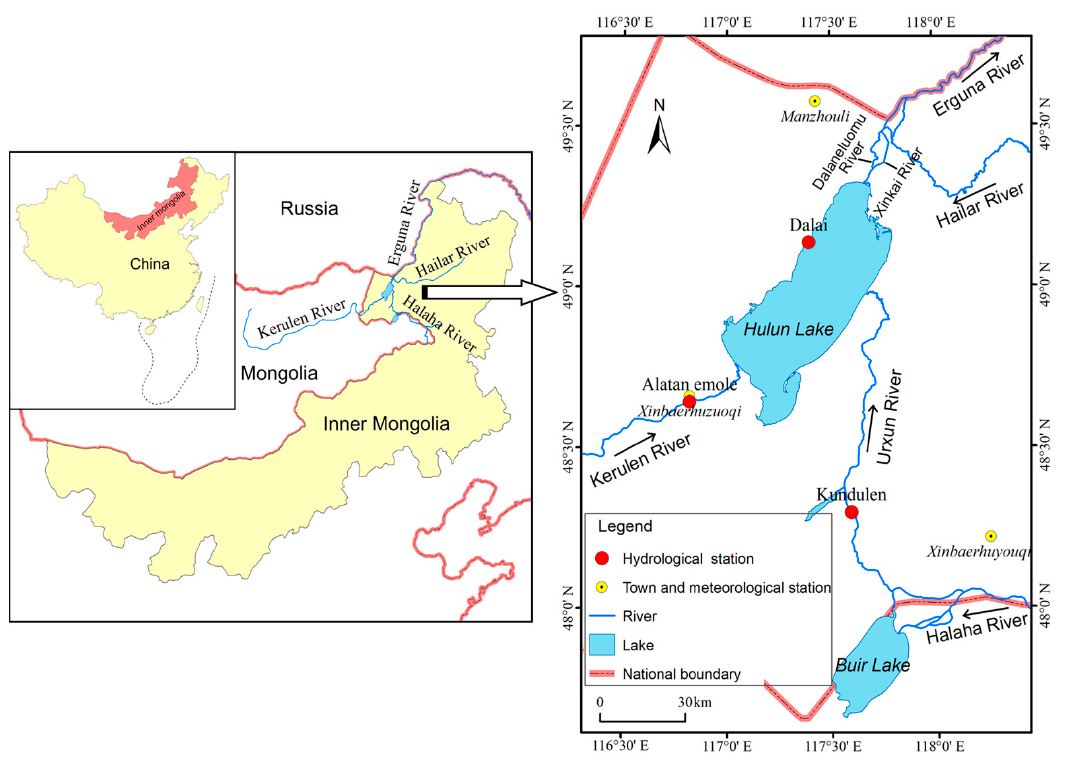
Figure 1. Geographic location of Hulun Lake and locations of monitoring stations. Hulun Lake has a large water-surface area (nicknamed the Prairie Pearl) and is located on the Hulunbeir grassland in the Inner Mongolia Autonomous Region. Hulun Lake and the surrounding grasslands, about 7400 km 2 in total, were designated a Provincial